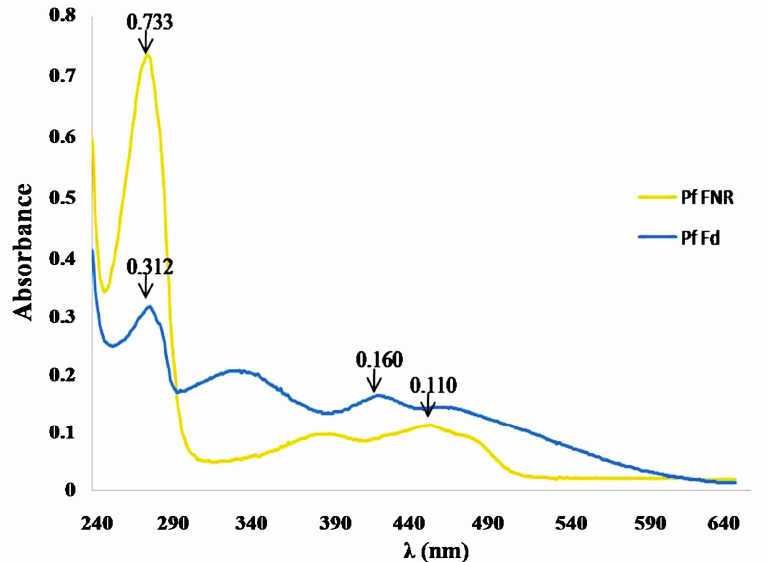
Figure 1. UV-Vis spectrum profile of the proteins Pf Fd and Pf